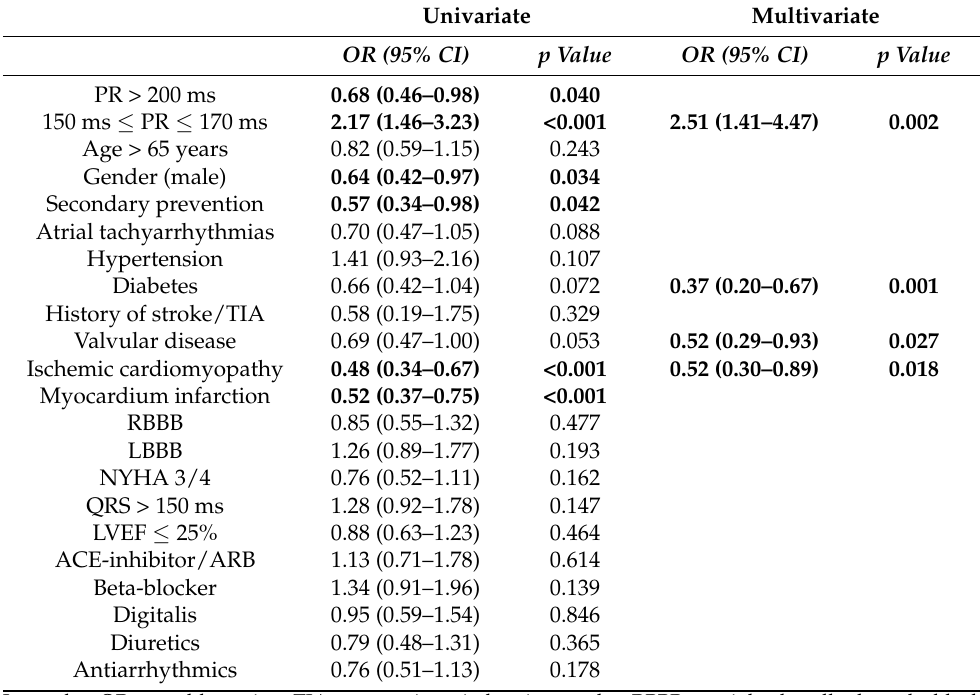
Table 2. Univariate and multivariate analysis of predictors of CRT response.